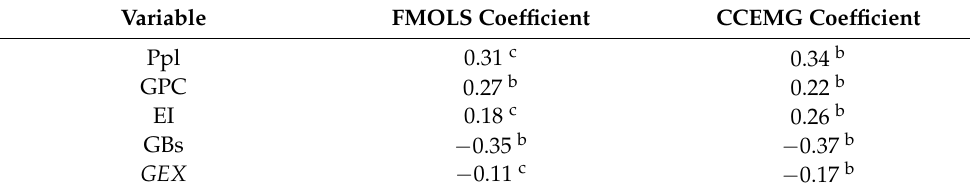
Table 10. FMOLS and CCEMG estimators for Robustness